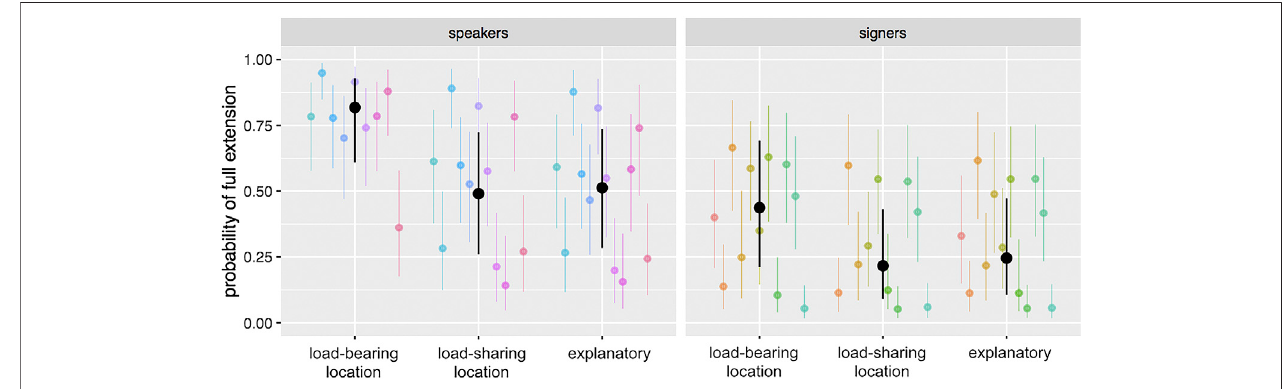
FIGURE 3 | Results from the model predicting the probability of using full arm extension, as a function of participant group and semantic function. Speakers were much more likely to use full extension overall, but in both groups load-bearing location points were more likely to involve full arm extension than other points. Black dots represent group means, and black lines represent 95% con fi dence intervals around those means; colored dots and lines represent individual participants.